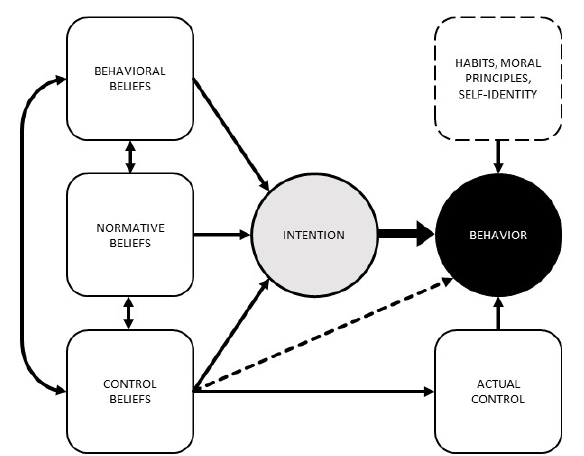
Figure 1. Theoretical framework (based on Ajzen